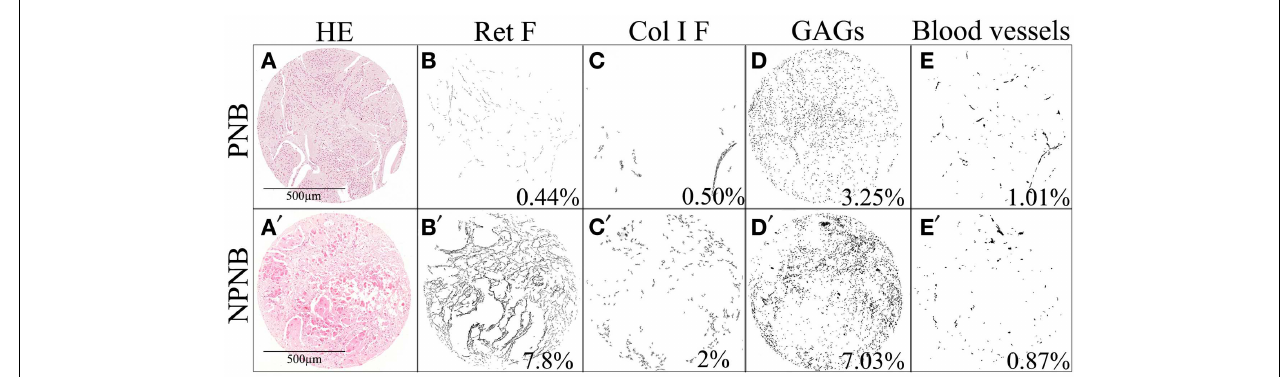
such a way that they are smaller in NPNB.The remodeling characteristics of the ECM components, with different mechanical properties, are differentially related to prognostically significant clinical and biological features in NB.The percentages of stained area are indicated. PNB, primary neuroblastoma; NPNB, non-primary neuroblastoma (after treatment); HE, hematoxylin and